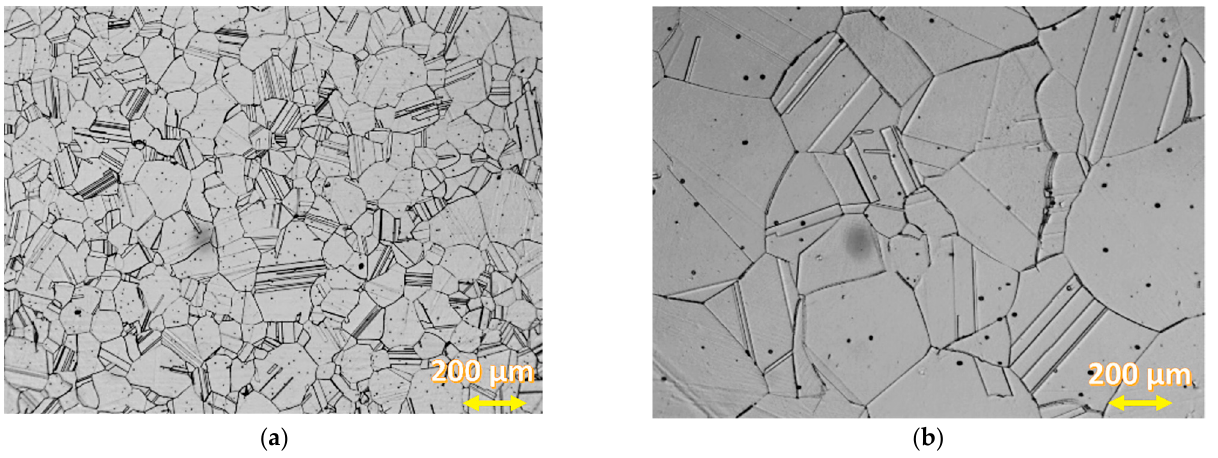
Figure 8. Alloy 59—( a , b ) austenitic microstructure under different